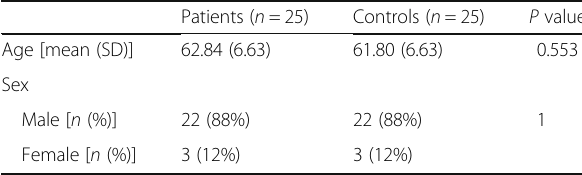
Table 1 Demographics of PD patients and controls